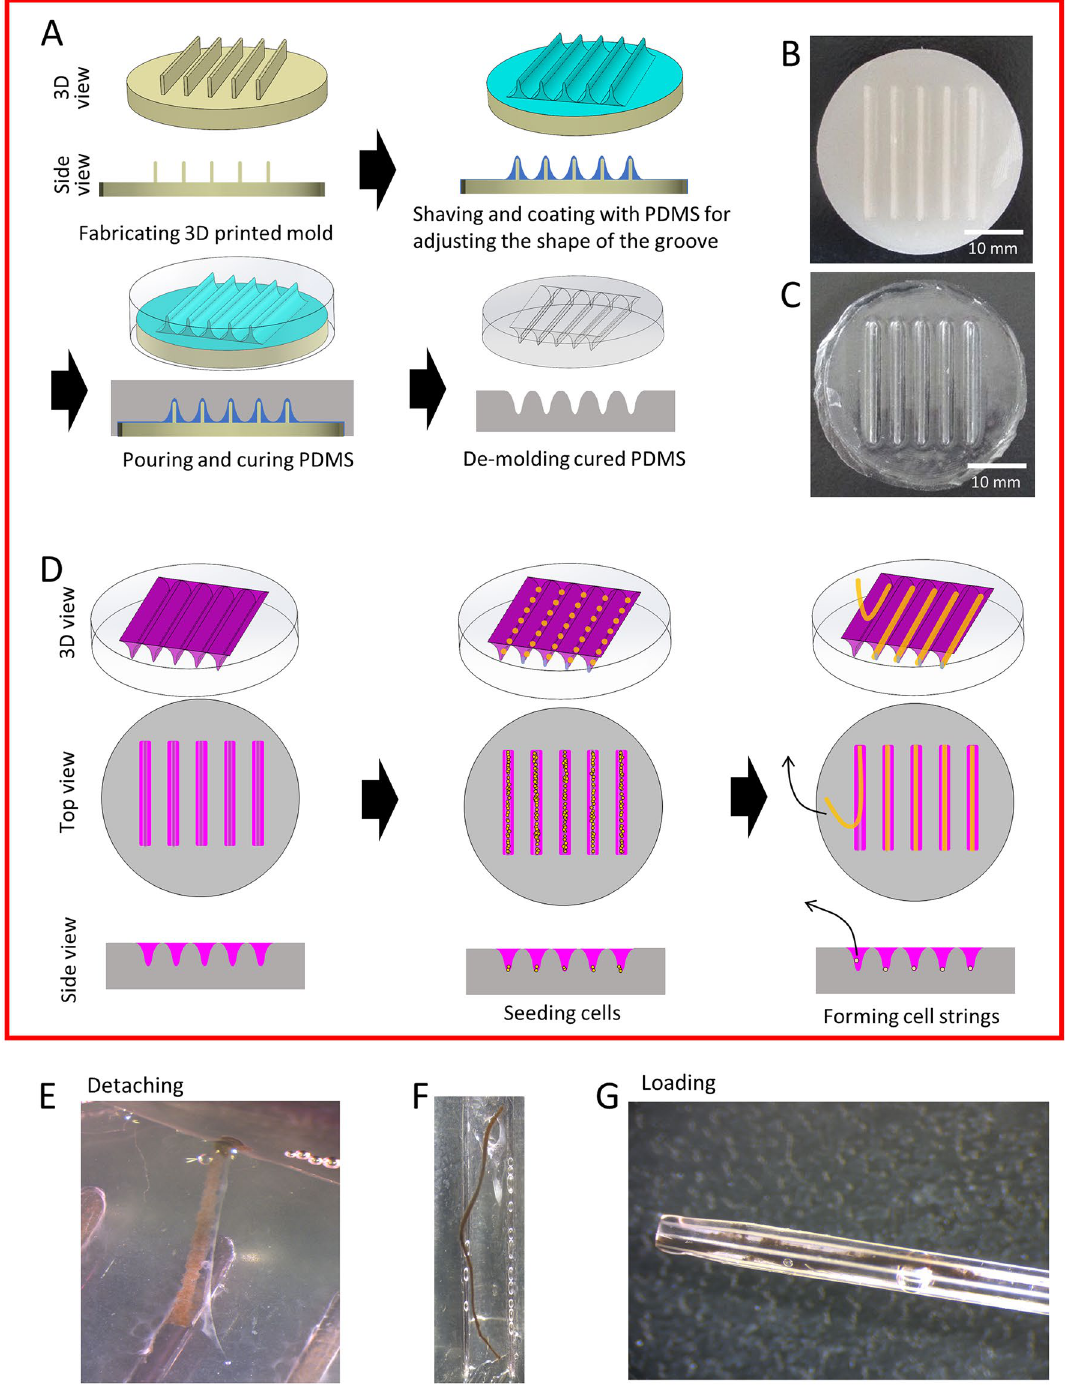
Figure 1. Manufacturing of a strip-form hiPSC-RPE. (A) Fabrication process of polydimethylsiloxane (PDMS)- based culture device for the formation of RPE-strips. (B) 3D printed mold. (C) PDMS-based culture device with grooves of 19.5 mm length, 1 mm width, and 1.6 mm depth. The PDMS mixture was poured over the mold, degassed, and then placed in an 80 °C oven for 3 h. See also Supplemental Fig. 1 for detailed data. (D) Procedure for making cell strips. RPE cells were seeded in each groove, which were left to form strips for two days. (E–G ) Representative images of hiPSC-RPE cells in a strip form that can be easily released from the mold (E,F) and loaded in a 24G cannula (G)